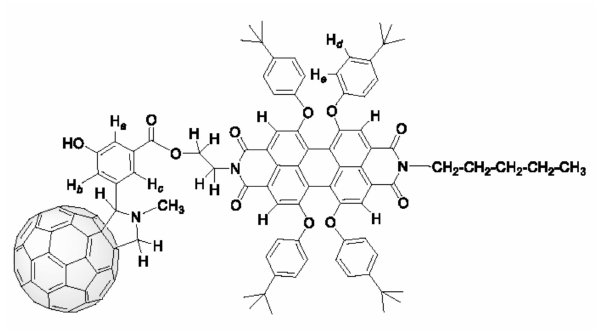
Figure 5. Formula of dyad 10 for 1 H NMR spectrum